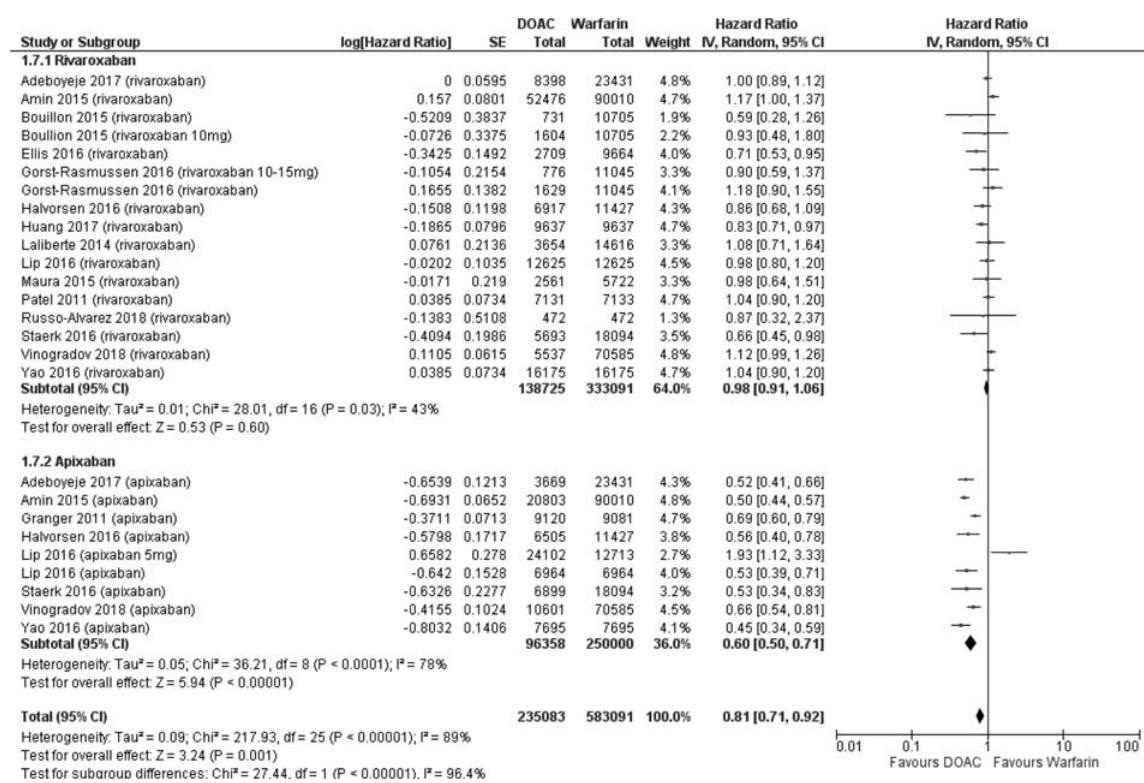
Fig. 3 Comparison of bleeding risk between direct factor Xa inhibitors and warfarin strati fi ed by individual